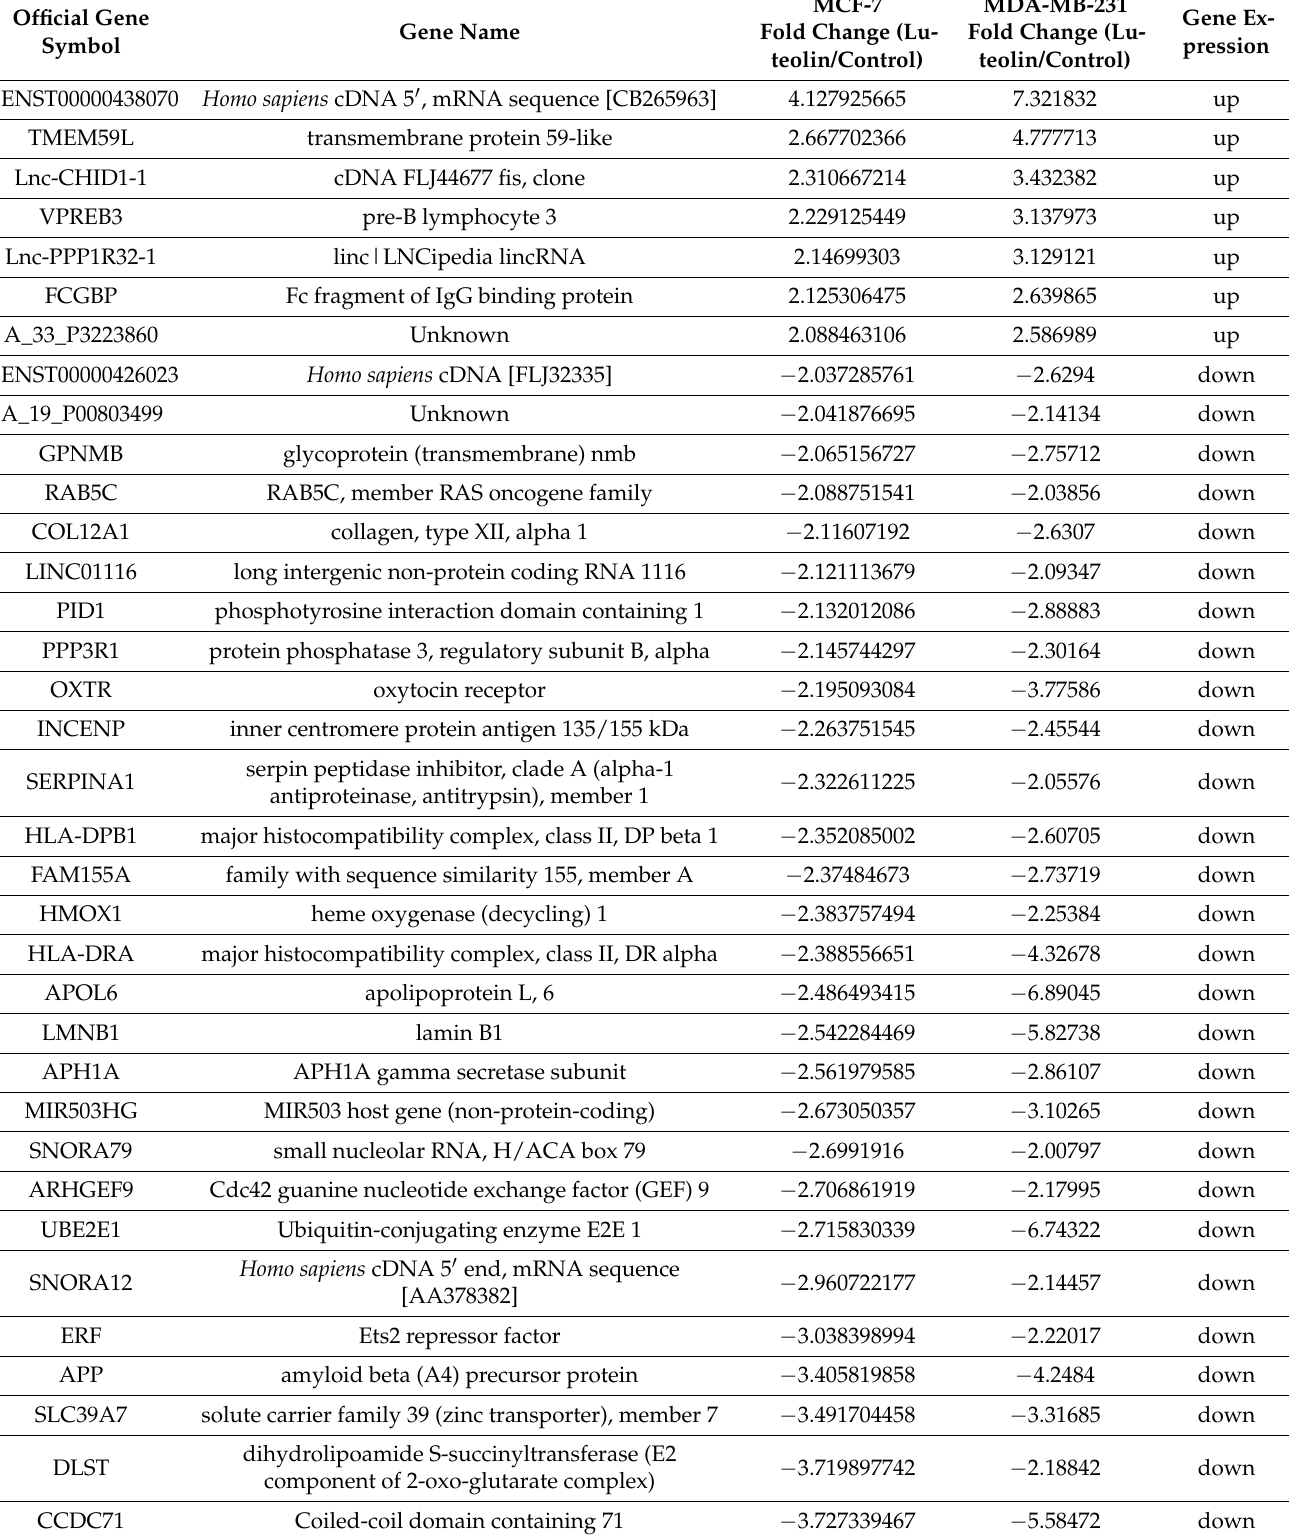
Table 1. Genes with significant changes in luteolin-treated MCF-7 and MDA-MB-231